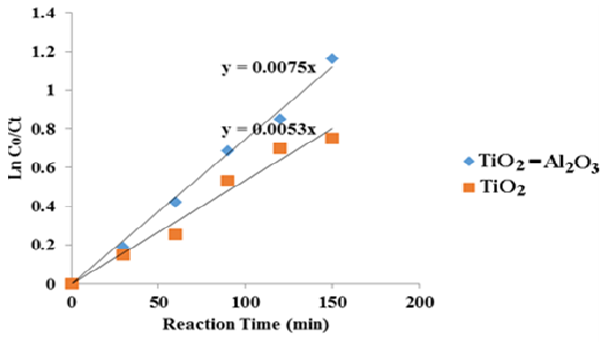
Fig. 9. Photo-catalytic degradation of methyl orange: effect of temperature.